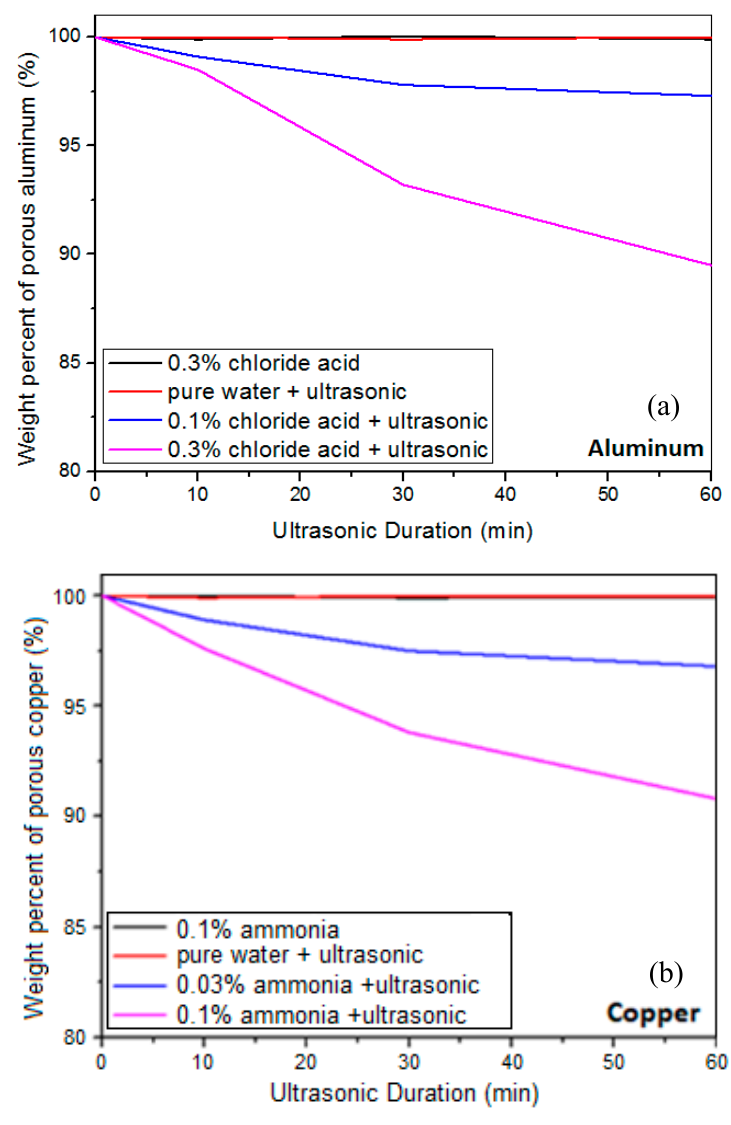
Figure 2. Effects of ultrasonication and the etching agent on the formation of nanopores on the surfaces of ( a ) aluminum and ( b ) copper foil.